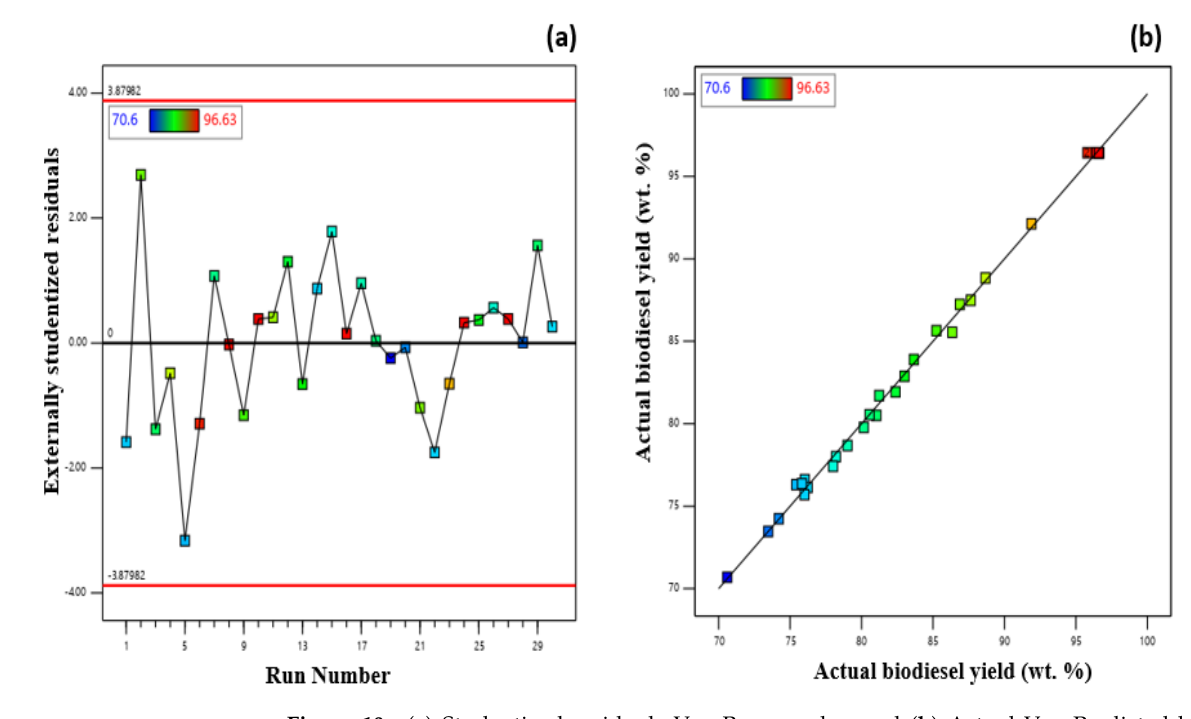
Figure 10. ( a ) Studentized residuals Vs. Run number and ( b ) Actual Vs. Predicted biodiesel yield (wt.%).